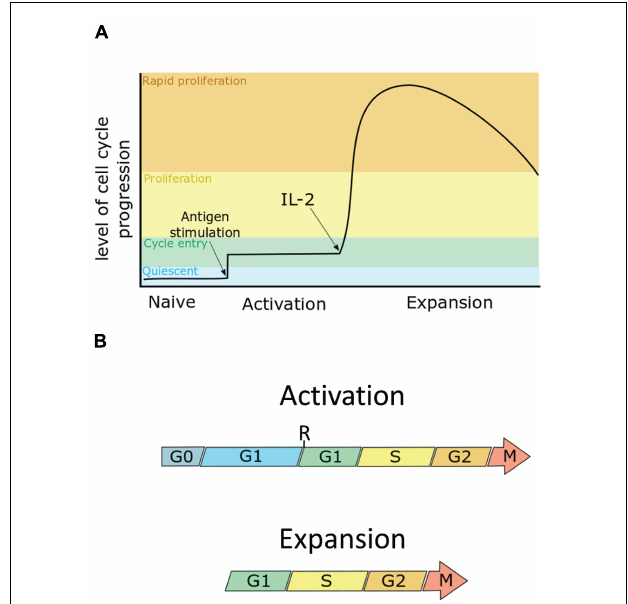
FIGURE 1 | The cell cycle can be split into four phases: the first gap phase (G1), DNA synthesis phase (S), the second gap phase (G2), and mitosis (M). G1 can be further subdivided into pre- and post- restriction point G1 (pre-R G1, post-R G1). Quiescent cells are in a G0 state. (A) Naïve T cells are cells in G0. Upon maximum stimulation by T-cell receptor-antigen and co-stimulation, murine CD8 + T cells enter the cell cycle, going through only a few divisions until they receive the IL-2 signal, at which point they proliferate rapidly as they enter the expansion phase. (B) During activation, T cells enter an extended G1 phase, in which cells increase in size by ∼ 3–4-fold, entering their first S-phase within 30 h. During the expansion phase, cells then undergo rapid proliferation, dividing as quickly as once every 4 h, to clonally expand the antigen-specific T cell pool. Arrows indicate continuation beyond mitosis into the next